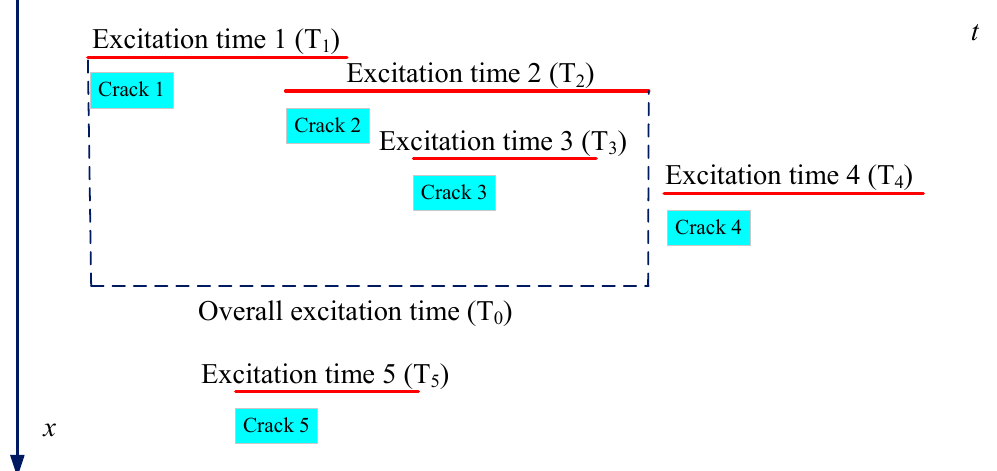
Figure 6. Definition of the same seismic event in terms of time; the occurrence order of cracks is Crack 1, 5, 2, 3, and 4, where Cracks 1, 2, and 3 belong to the same seismic event.